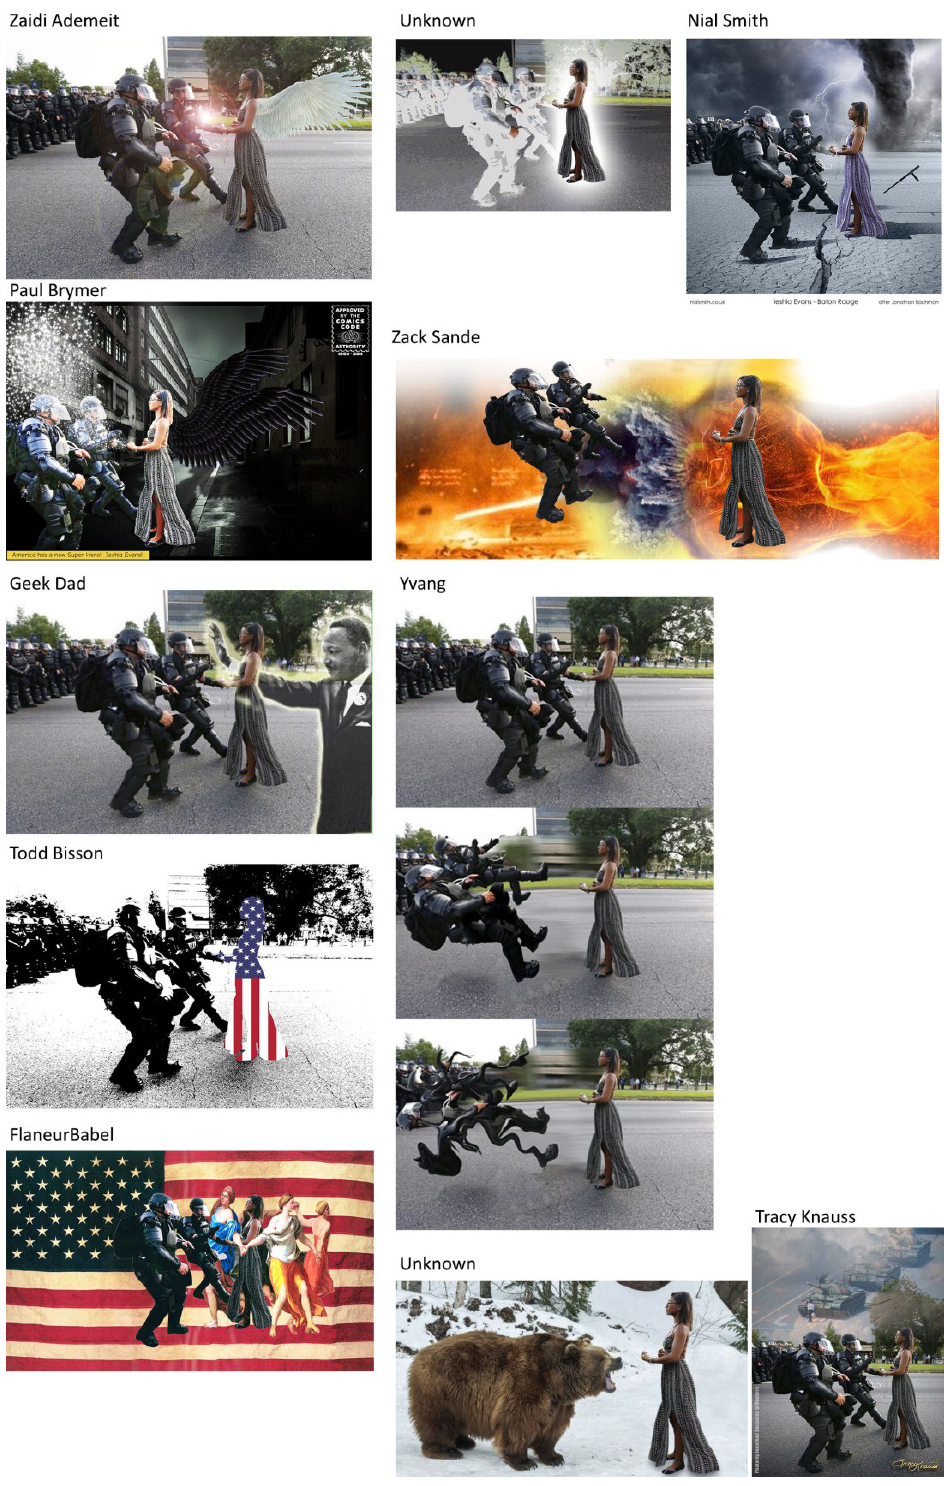
Figure 8. Photoshop-style manipulations. Source: Twitter.